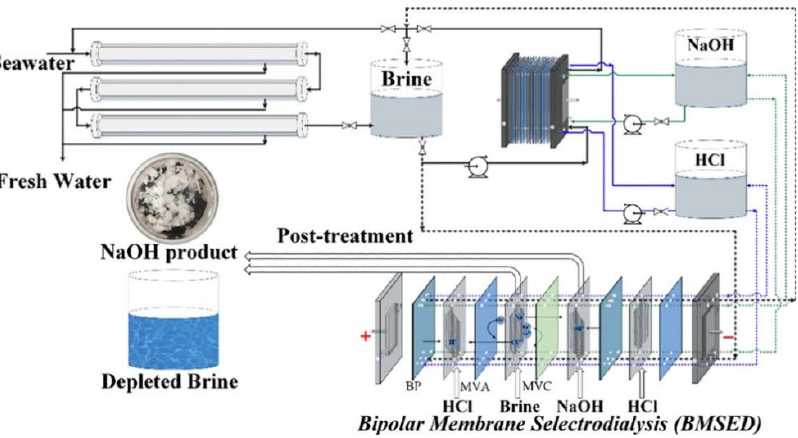
Figure 2. Schematic diagram of the BMSED process [30].